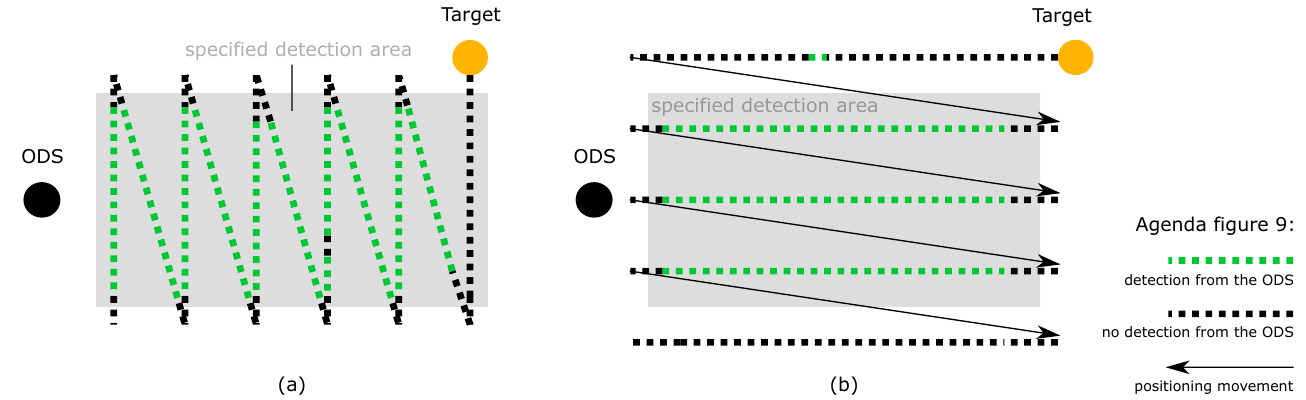
Agenda figure 9: detection from the ODS